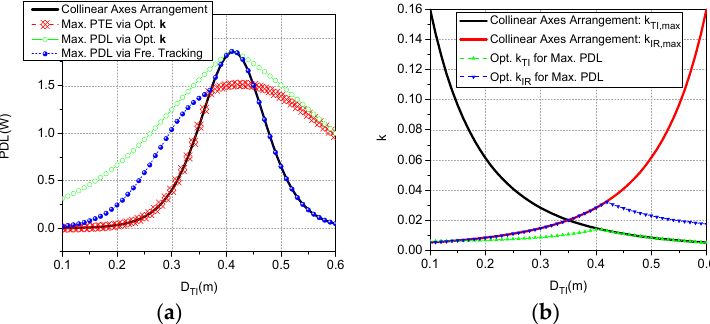
Figure 7. ( a ) Comparison between maximizing PDL goal by optimizing coupling coefficient vector, k , and three other power transfer scenarios. ( b ) Comparison between maximal coupling coefficient vector, [ k TI,max , k IR,max ], of collinear axes arrangement scenario and optimal coupling coefficient vector, [ k TI , k IR ], for maximizing PDL goal.